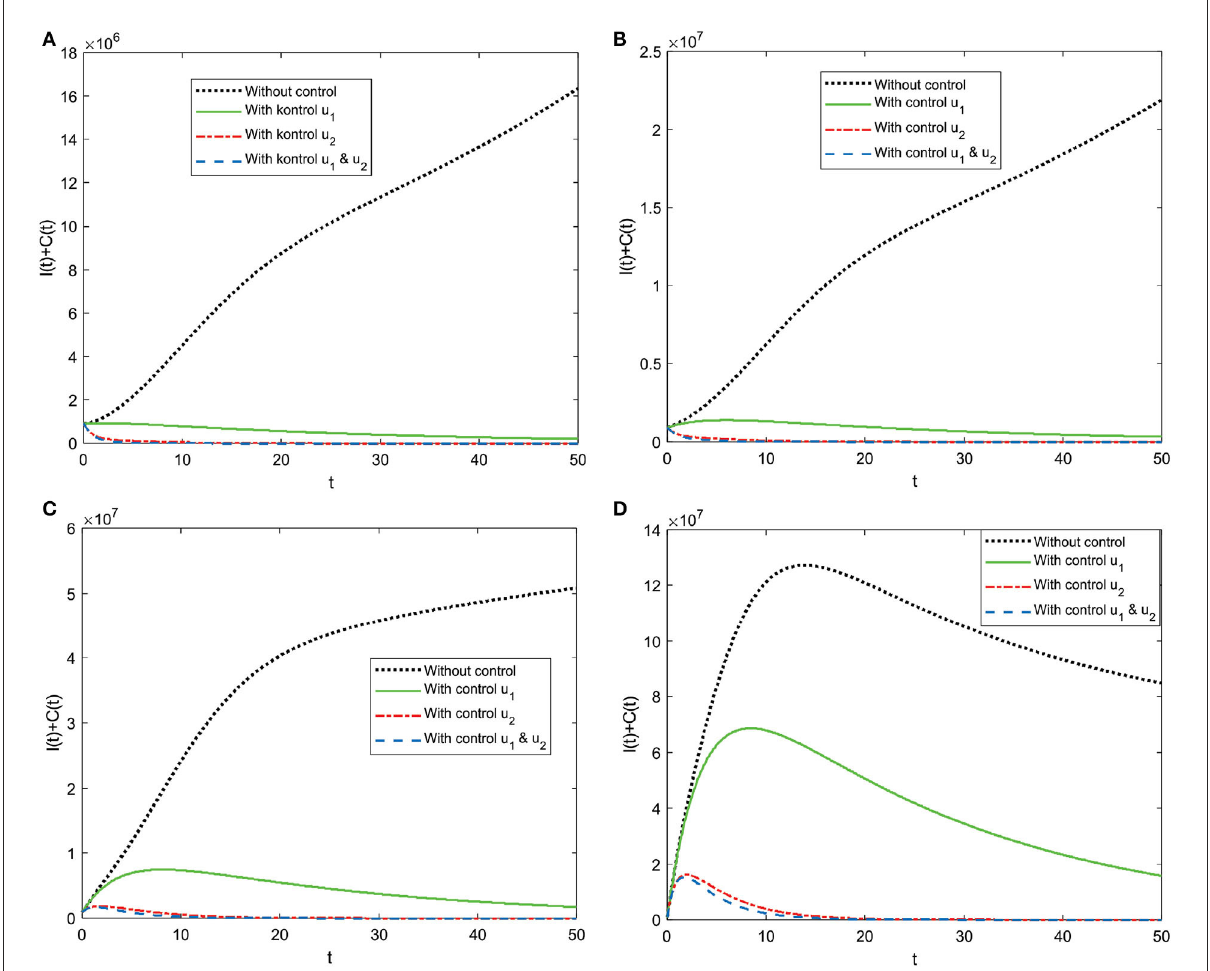
FIGURE13 (A–D) Total subpopulation infected using various strategies.